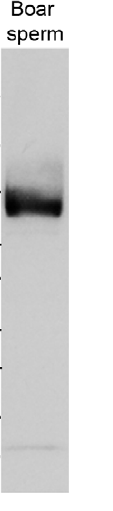
Figure 8. Western blotting of PPi transporter protein ANKH in boar spermatozoa (anticipated mass: 76 kD). midpiece, which provide energy for sperm movement and sperm- zona penetration during fertilization. Higher percentages of polarized, live spermatozoa were observed in semen preserved with 10 m M PPi at day 3 and day 10 of storage. Thus, PPi improved sperm survival and sustained mitopotential during extended semen storage. Sperm viability decreases during storage, and reduces sperm fertilizing ability due to the loss of ATP and cAMP, and reduced calcium uptake [40]. This could be a result of accelerated sperm metabolism and ATP utilization, or reduced sperm ATP output in the presence of an alternative energy source in form of PPi.